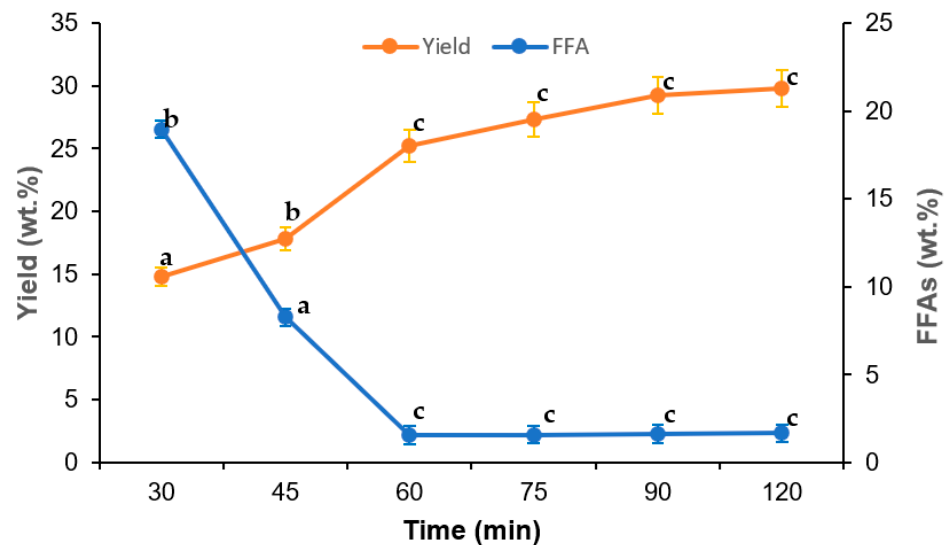
Figure 3. Effect of sterilization time in VPO extraction using cold press technology. Experimental conditions: temperature 60 °C; amount of fresh palm fruits: 5 kg. Means of triplicates ± standard deviation. Means followed by different letters in the same line demonstrated significant difference by Tukey test ( p < 0.05).